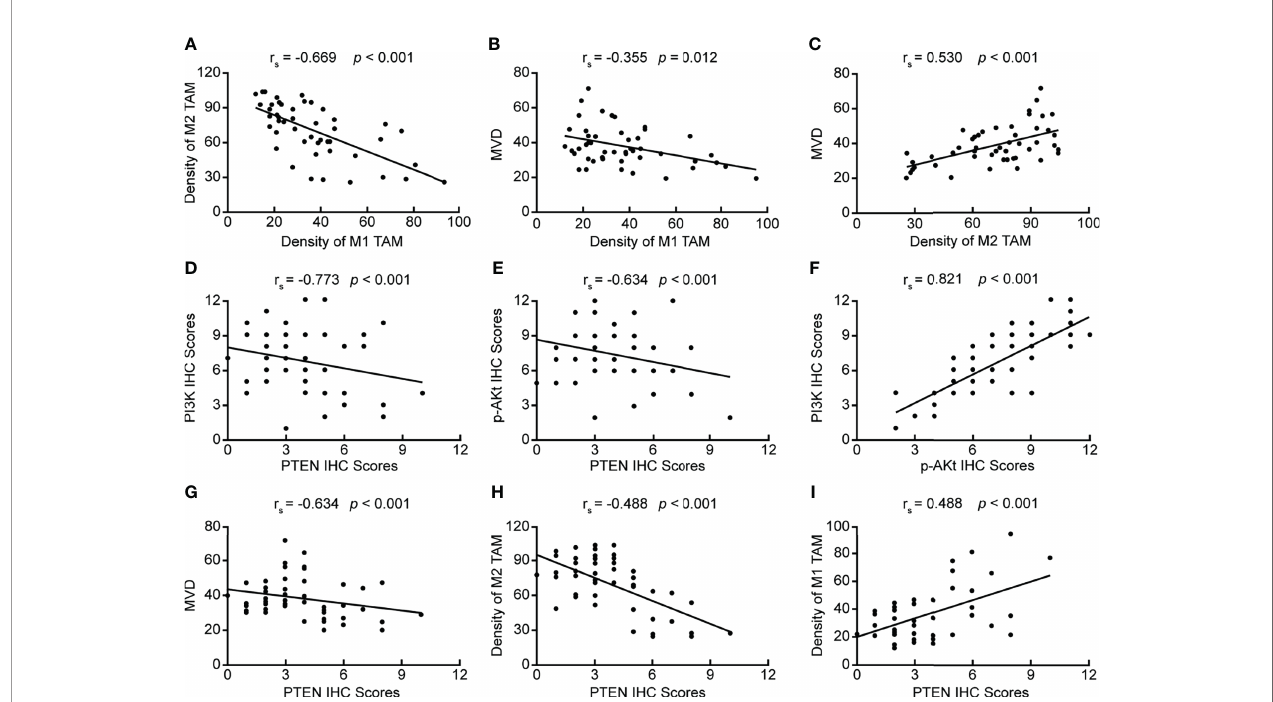
FIGURE 2 | Correlation between PTEN/PI3K/AKT expression, the number of in fi ltrating TAMs, and MVD value. (A) Correlation between the numbers of in fi ltrating M2 TAMs and M1 TAMs; (B) Correlation between the numbers of in fi ltrating M1 TAMs and MVD value; (C) Correlation between the number of in fi ltrating M2 TAMs and MVD value; (D) Correlation between PI3K and PTEN protein levels; (E) Correlation between p-AKT and PTEN levels; (F) Correlation between PI3K and p-AKT levels; (G) Correlation between PTEN expression and MVD value; (H) Correlation between PTEN expression and the number of in fi ltrating M2 TAMs; (I) Correlation between PTEN expression and the number of in fi ltrating M1 TAMs. p < 0.05 was considered to be statistically signi fi